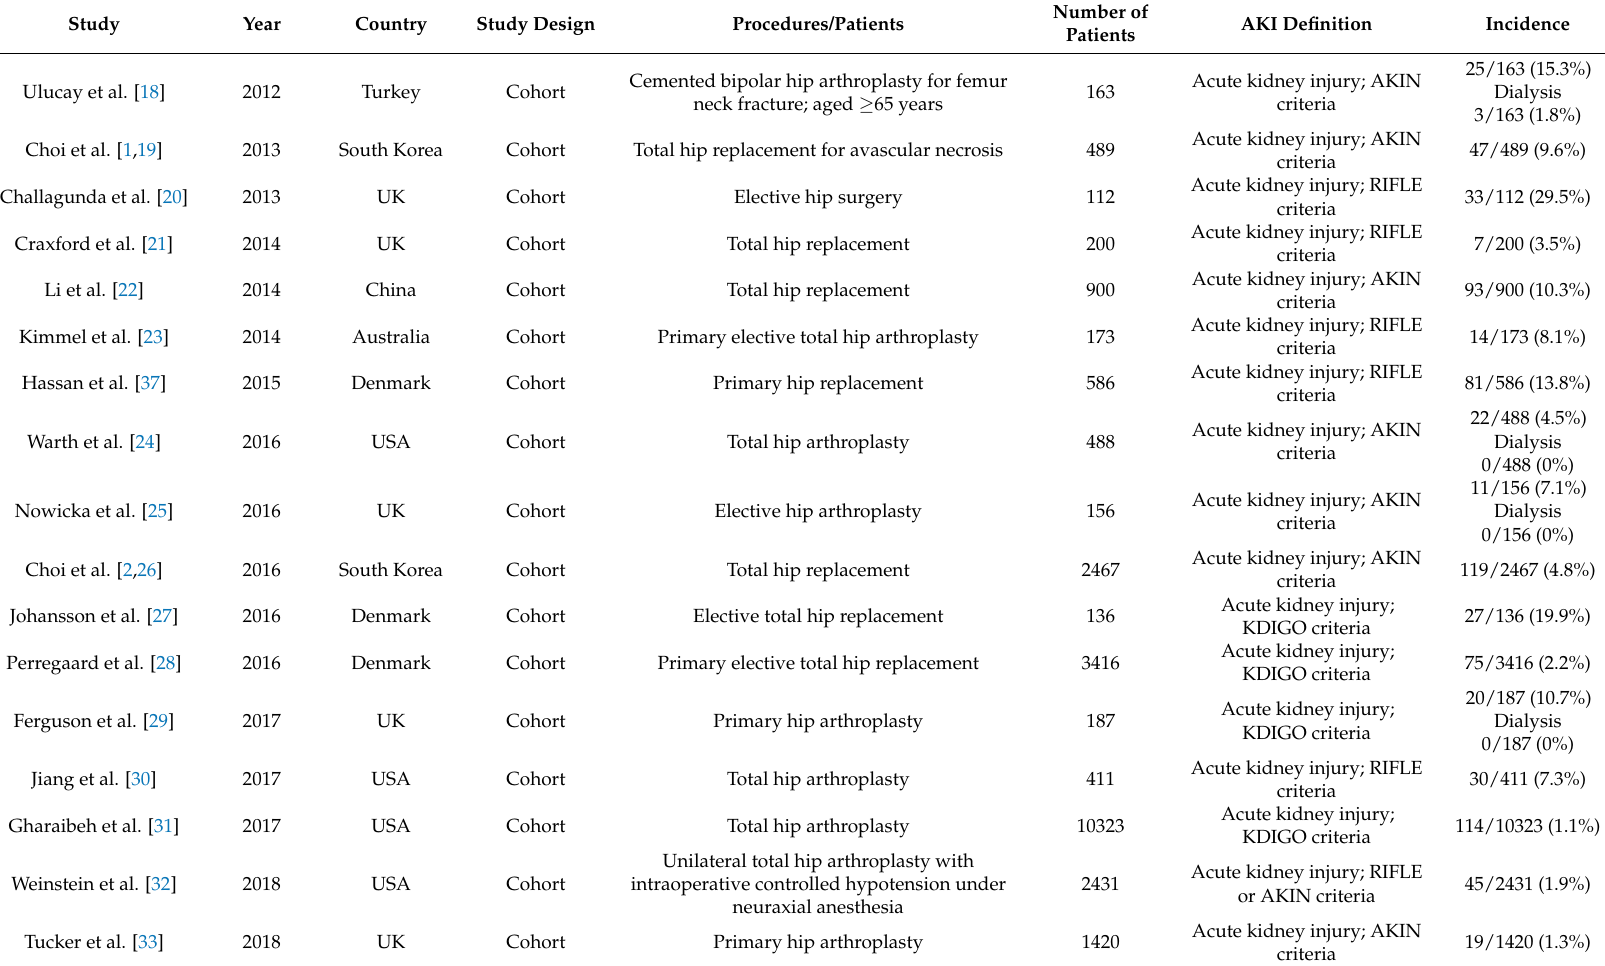
Table 1. Main characteristic of studies included in meta-analysis of AKI incidence in patients undergoing THA